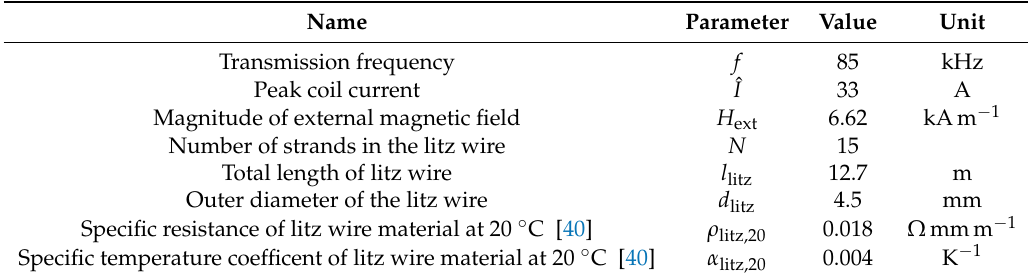
Table 3. Parameters for the calculation of coil losses P coil ( T )